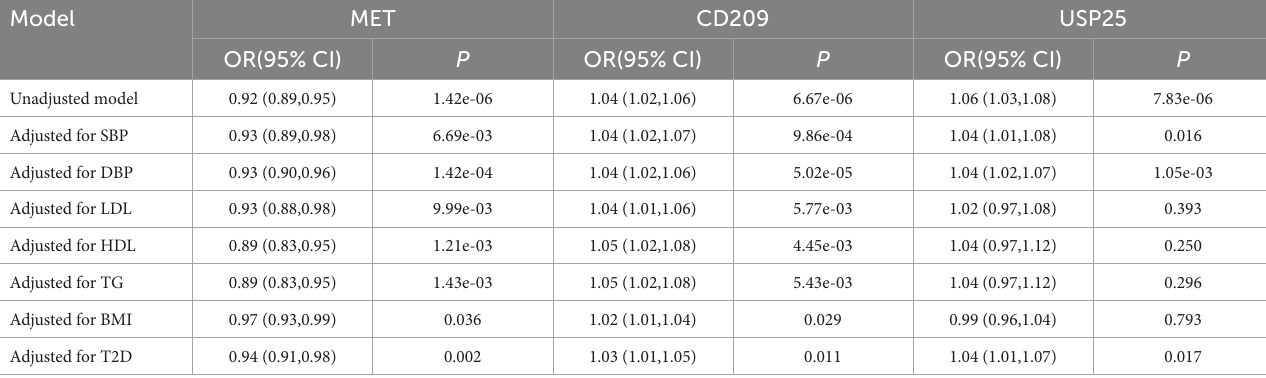
TABLE 2 Multivariable Mendelian randomization associations of risk proteins with heart failure adjusting for potential confounders.